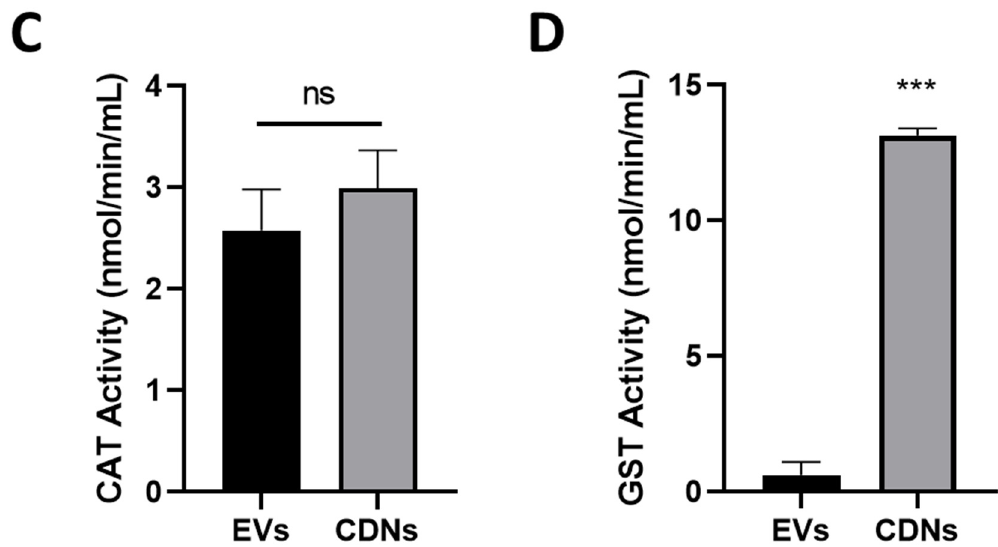
Figure 5. ( A ) Total antioxidant capacity of U937 EVs and U937 CDNs. Data presented as mean ± SEM ( n = 5). ( B ) Detoxification of ROS by cellular antioxidant enzymes. In the first line of defence, antioxidant enzymes such as SOD and CAT can convert ROS into oxygen and water. In the third line of defence, antioxidant enzymes such as GST could detoxify oxidised biomolecules and repair damage caused by free radicals. ( C ) Catalase activity of U937 EVs and U937 CDNs. Data presented as mean ± SEM ( n = 4). ( D ) Glutathione S-transferase activity of U937 EVs and U937 CDNs. Data presented as mean ± SEM ( n = 3). ns, no statistical di ff erence; ***, p < 0.001.